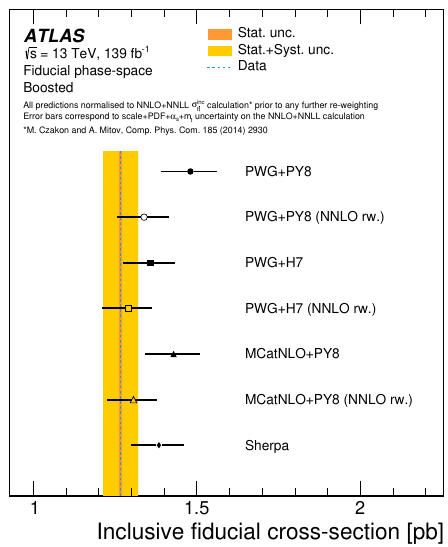
Figure 9. The fiducial cross-section at particle level for boosted t ¯ t production measured in data (dashed line) is compared with several NLO predictions (closed markers). All the MC samples are normalised to the NNLO+NNLL prediction for the total t ¯ t cross-section ( σ inc ). The open t ¯ t markers show the predictions from the MC generators after they were reweighted at parton level to match NNLO predictions for p ( t ) , m ( t ¯ t ) and p ( t ¯ t ) . The yellow band represents the total T T uncertainty of the measured cross-section, while the orange band shows the statistical component. The uncertainties in the predictions are evaluated as the quadrature sum of the α , PDF, m s t and scale uncertainties present in the NNLO+NNLL prediction. PWG+PY8 corresponds to the Powheg+Pythia sample, PWG+H7 to the Powheg+Herwig sample, and MCatNLO+PY8 to the MadGraph5_aMC@NLO+Pythia